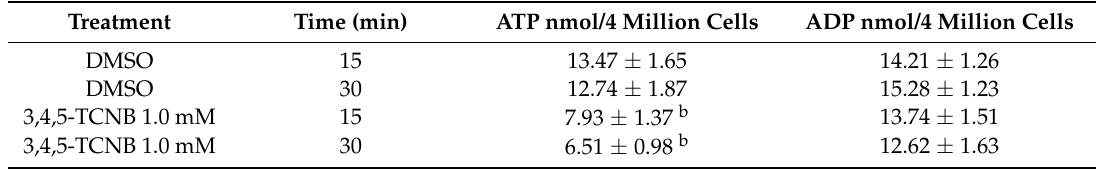
Table 4. Effect of 3,4,5-TCNB on ATP and ADP a .